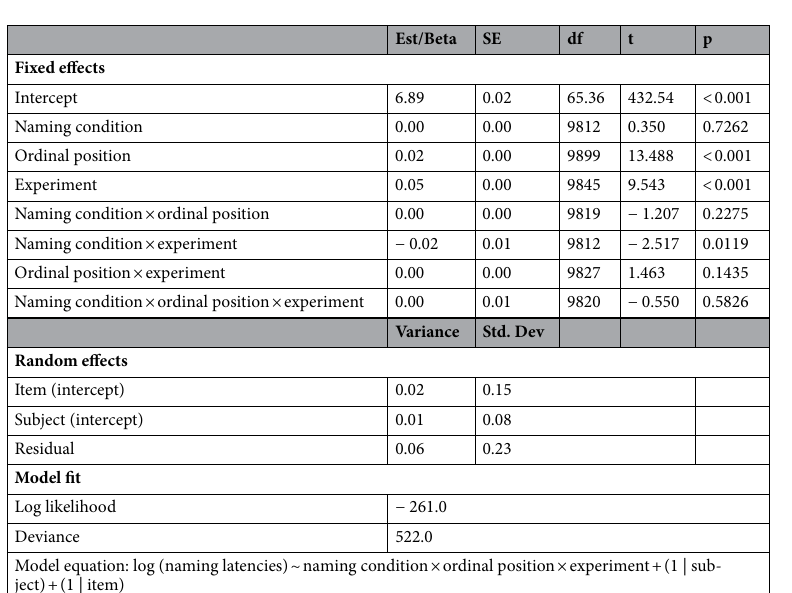
Table 2. LMM for the combined robot and human datasets. Fixed-effect estimates, standard errors, degrees of freedom, t- values and p-values for the selected model of the Robot as a Task Partner and Human as a Task Partner Experiments; estimates of the variance and square root (standard deviations) of the random effect structure and goodness-of-fit statistics are also